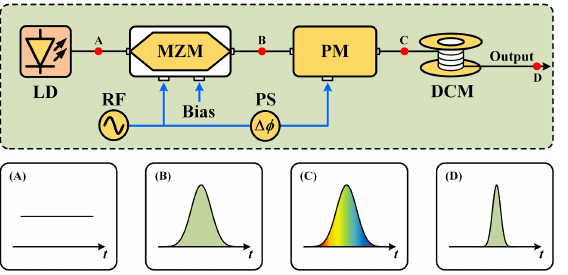
Figure 4. Architecture of the cavity-less ultra-short optical pulse source. ( A ) Temporal waveform from LD. ( B ) Temporal waveform from MZM. ( C ) Temporal waveform from PM. ( D ) Temporal waveform from DCM. LD: laser diode; RF: radio-frequency; MZM: Mach-Zehnder modulator; PS: phase shifter; PM: phase modulator; DCM: dispersion compensation